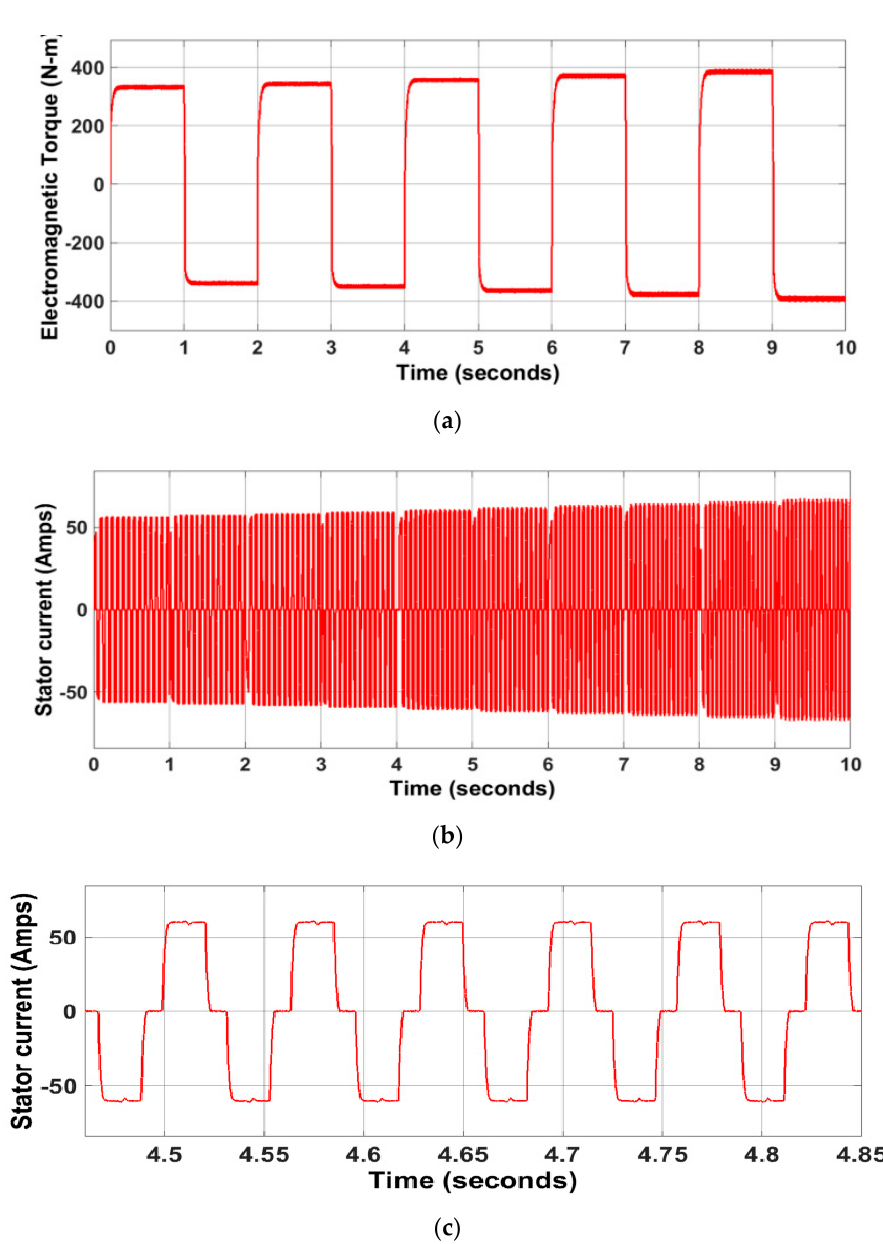
Figure 16. ( a ) Electromagnetic torque developed by a motor using the parameters of 1040 HR; ( b ) stator current in Phase A of a motor using the parameters of 1080 HR steel; ( c ) expanded stator current waveform in Phase A of motor corresponding to 1080 HR steel.